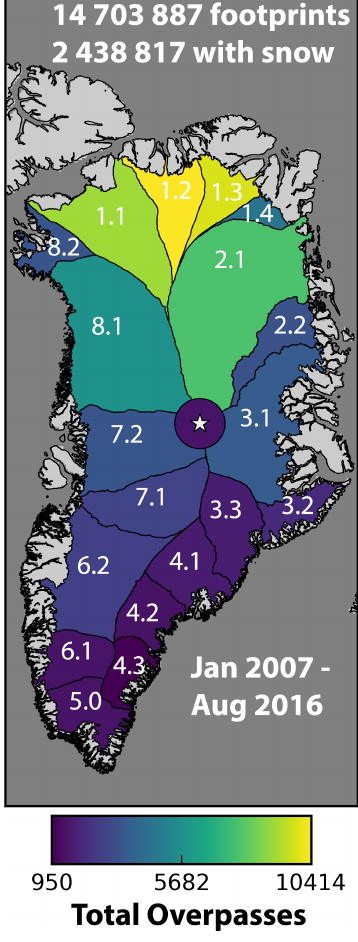
Figure 1. A summary of the CloudSat/CALIPSO satellite obser- vations collected over the Greenland Ice Sheet (GrIS). The GrIS is divided into the drainage basins defined by the Ice Altimetry Group at the Goddard Space Flight Center (Zwally et al., 2012). The color scale represents the total number of satellite overpasses in each basin during the full study period, January 2007 through August 2016. During that period, there were 14703887 individual satellite observations, 2438817 of which contained snowfall. The star indicates the location of Summit Station, and the circle is the 100km radius surrounding